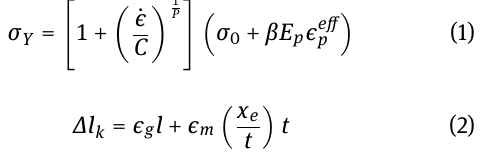
used to idealize side shell, frame, deck and other struc- tural components. Deformation due to interaction with container in collision was assessed in discussion which deformable material characteristic is applied in